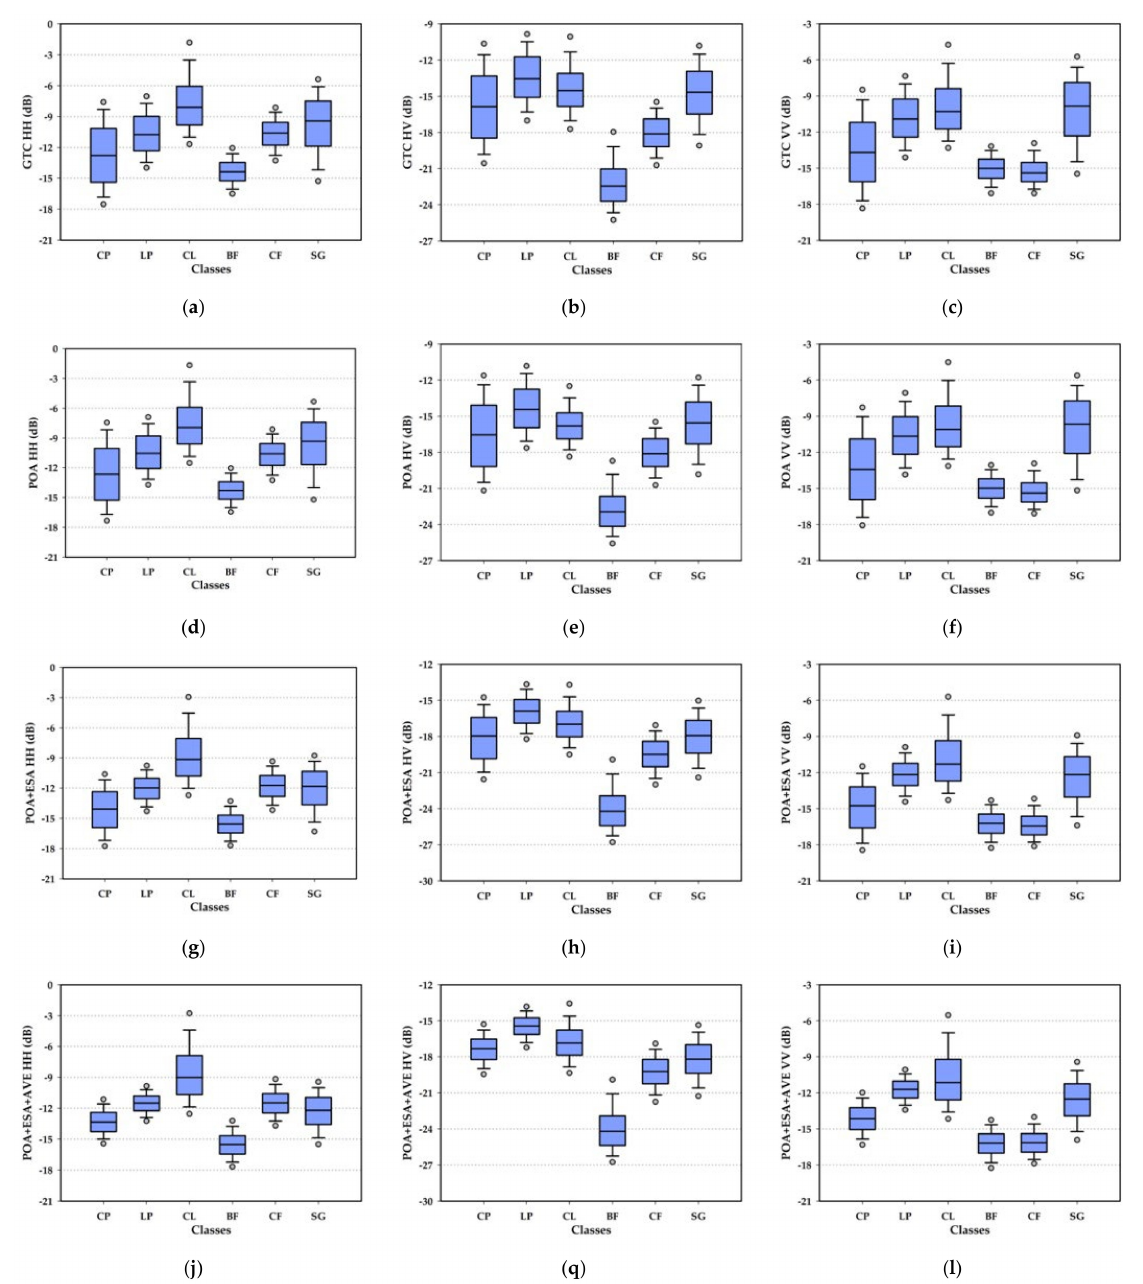
Figure 10. The boxplots of different classes for different polarization channels at different